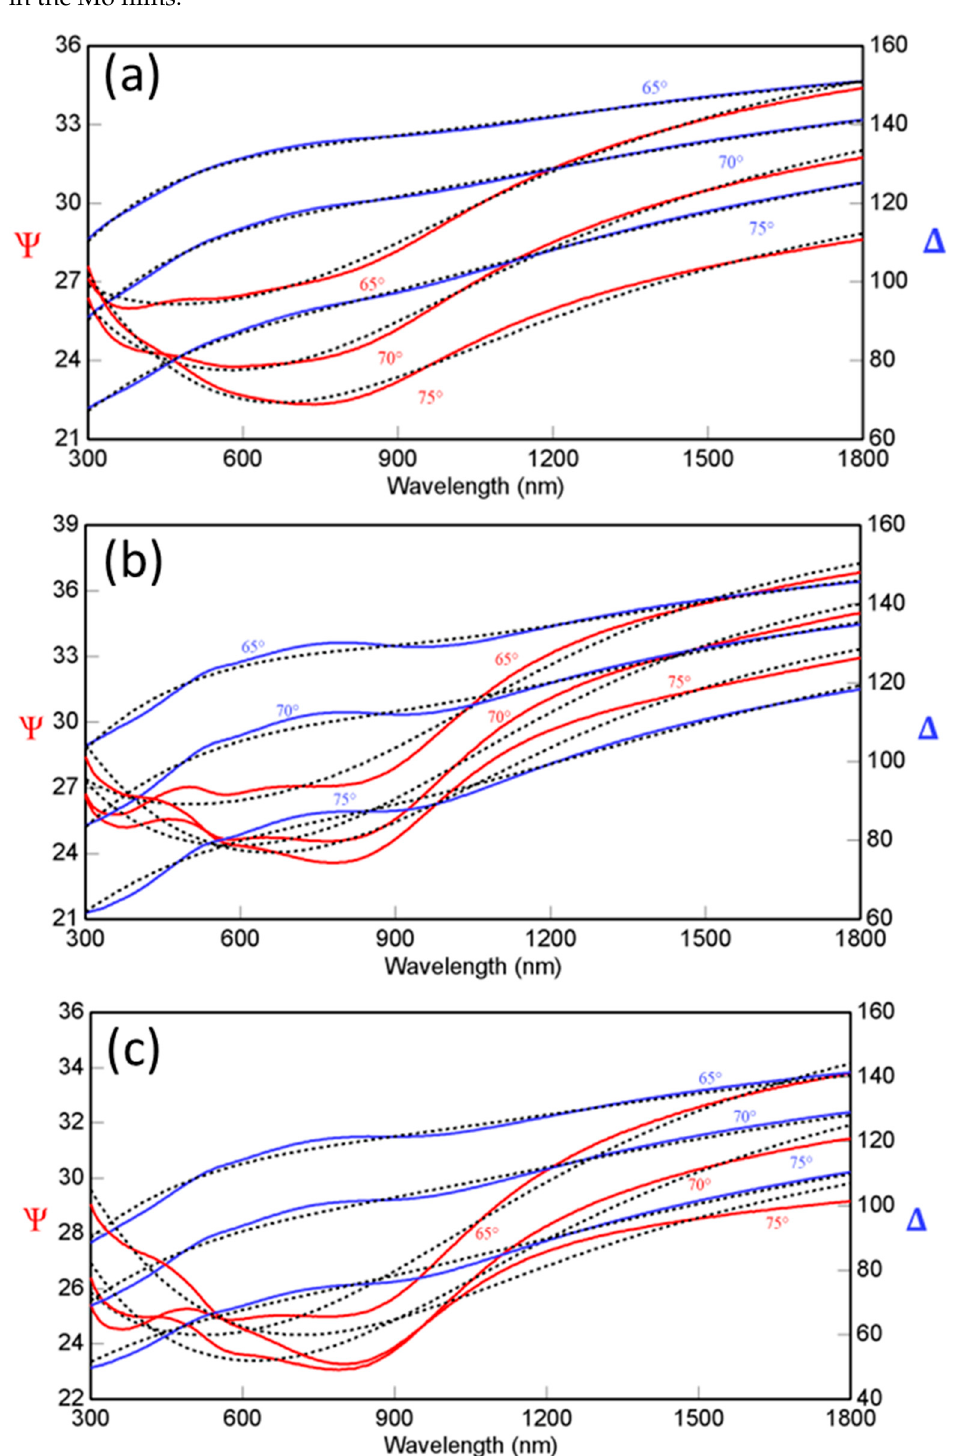
Figure 7. The spectral dependencies of the SE functions, Ψ and Δ , measured for nanocrystalline Mo samples. The experimental and simulated curves (as indicated by the solid and dashed lines respectively) for Δ and ψ are shown. The data shown are for Mo samples deposited at—( a ) 25 °C, ( b ) 300 °C, and ( c ) 500 °C. A high degree of agreement between the curves is indicative of accurate modeling and is needed for reliable derivation of optical constants.